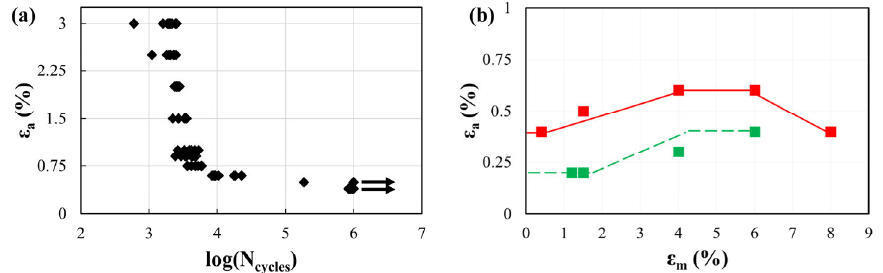
Figure 2. Results of a uniaxial tensile fatigue characterization performed on tensile wire specimens. ( a ) A strain–life diagram, performed at a fixed mean strain of 4%, where each point represents a failed sample; few samples reached the run-out of 1 million cycles and are represented by the arrow; ( b ) a constant-life diagram, considering the fixed threshold of 1 million cycles, where the solid line is an interpolation of the loading conditions leading to the failure of all samples (failure limit curve); the dashed line is an interpolation of the loading conditions leading to no failure (safe limit curve). Adapted with permission from [14] (Elsevier, 2023).